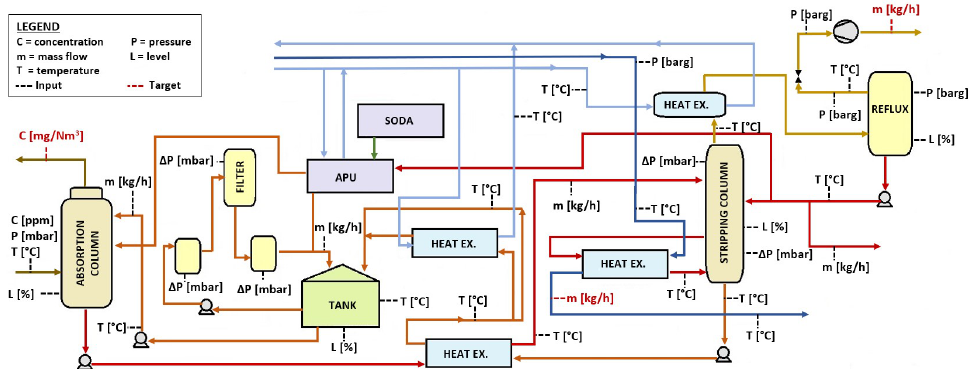
Figure 1. Scheme of SO 2 removal system located in the plant in southern Italy. The arrows represent the fluxes entering and exiting the equipment. The input variables are shown in black, whereas the targets are shown in red. Both are connected to the measurement points with dotted